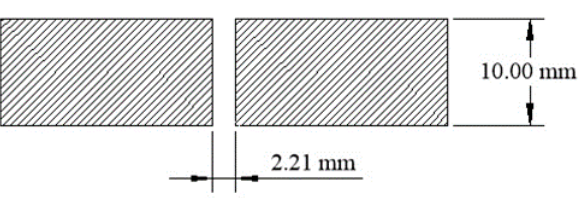
Figure 7. Optical cavity cross section, lens side.